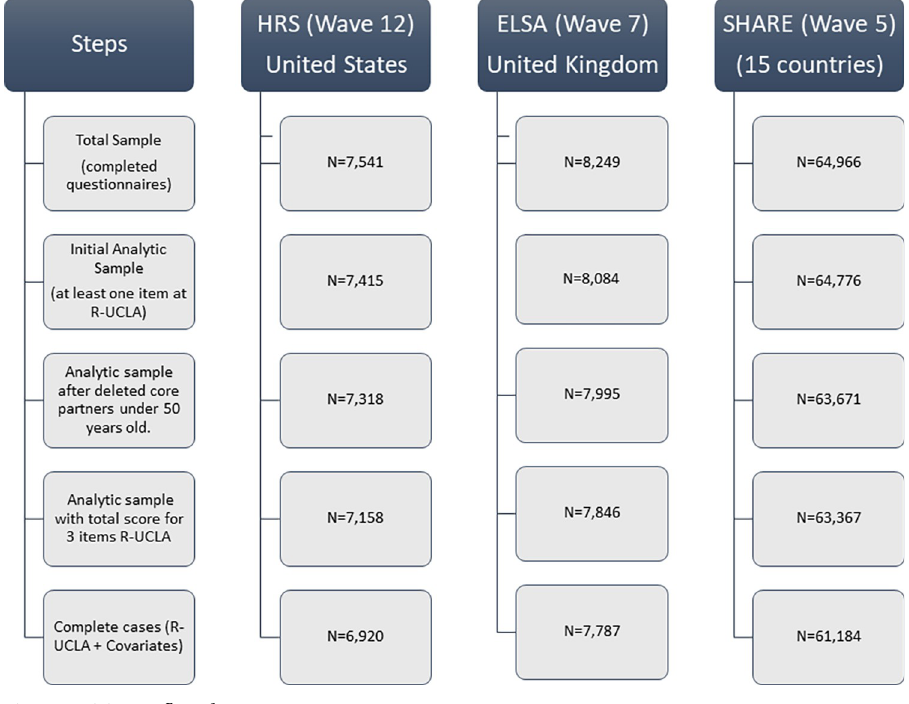
Fig 1. Participants flow